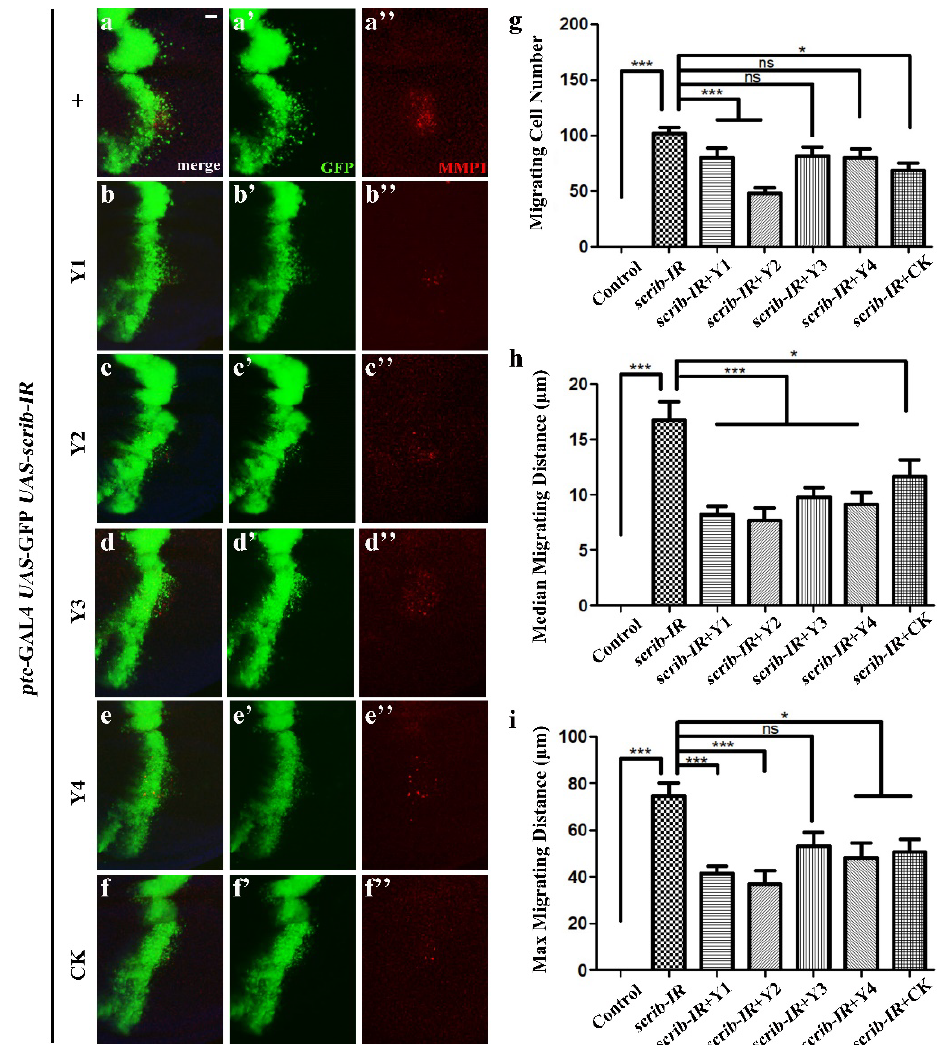
Figure 3. Dandelion extracts impede cell migration and MMP1 up-regulation. ( a – f ) Fluorescence micrographs of third instar larval wing discs were shown, anterior was to the left and dorsal up. The endogenous MMP1 expression was marked by anti-MMP1 antibody (red). Column bar graph of the migrating cell number ( g ), median migrating distance ( h ) and max migrating distance ( i ) as shown in ( a – f ) ( n = 20 for each genotype), error bars indicate standard deviation. One-way ANOVA with Bonferroni multiple comparison test was used to compute p -values, *** p < 0.001, * p < 0.05; ns, no significant difference. Scale bar: 20 µ m ( a – f ). CK: mother plant; Y1–Y4, represented the dandelion progenies originated from calluses that treated under NaCl concentration of 85 mM, 136 mM, 170 mM and 205 mM,